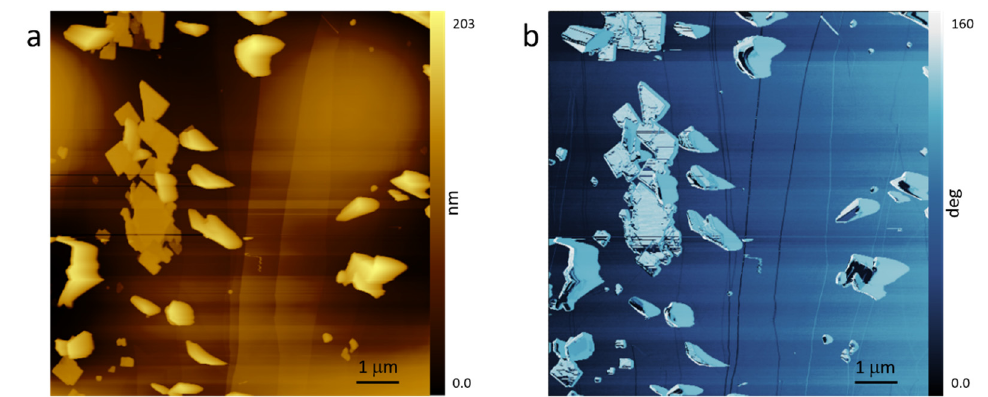
Figure 6. A (8 × 8) μ m 2 AFM image acquired on the H 2 Po 10 nm thick sample: ( a ) topography; ( b ) phase-contrast image. The HOPG substrate is exfoliated along the vertical direction.